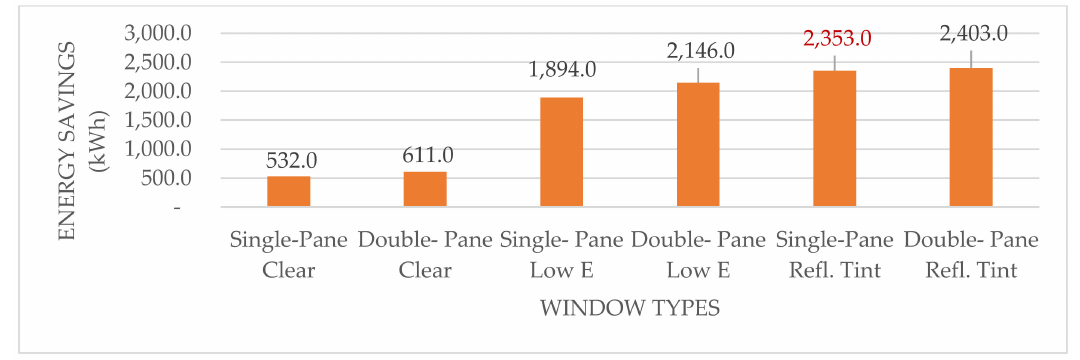
Figure 13. Annual energy savings per using di ff erent type of energy e ffi cient